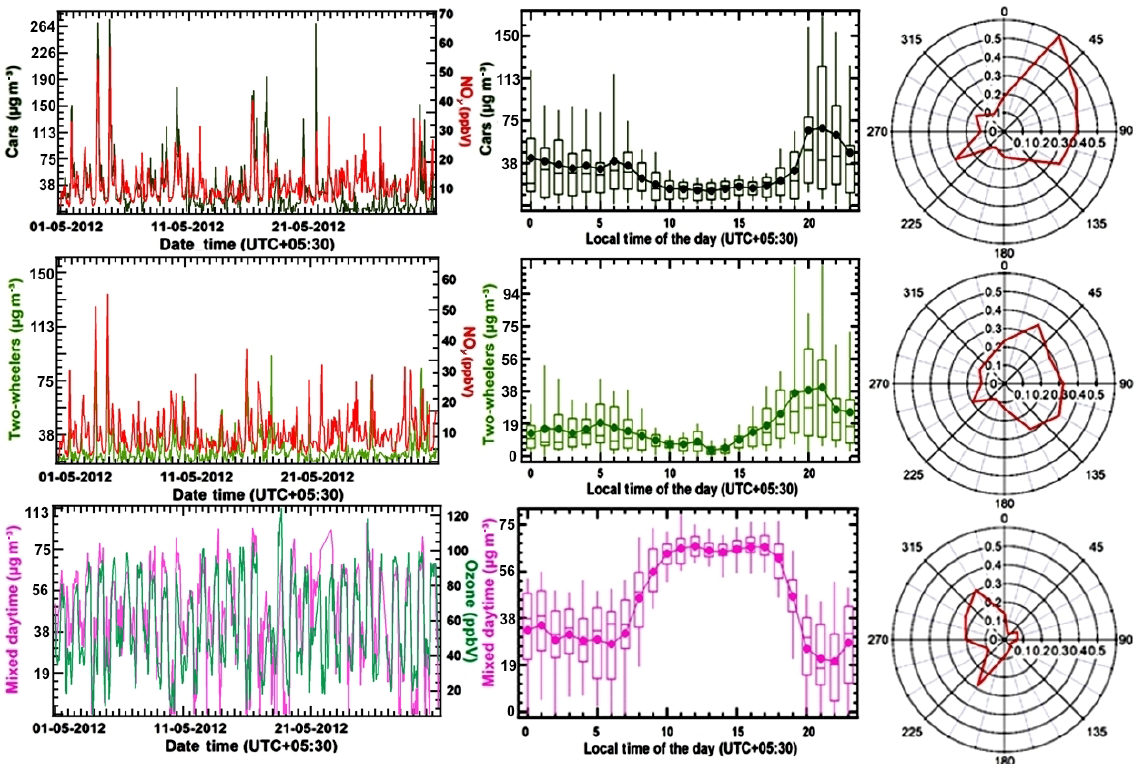
Figure 7. Factor contribution time series, factor diel variability and CPF plot for PMF factor 4 and factor 5 (cars and two-wheelers) and PMF factor 6 (mixed daytime) for May 2012. The time series of PMF factor’s hourly mass (in µgm − 3 ) is plotted against independent tracer species NO y (in ppbv) for the car and two-wheeler factor and O 3 (in ppbv) for the mixed daytime factor. The diel box-and-whisker plot shows the statistical parameters of factor’s hourly mass contribution (in µgm − 3 ) for every hour of the day plotted against the start time of the hour. The width of the box gives 25th and 75th percentiles, 50th percentile partitions the box; whiskers represent 10th and 90th percentiles of the dataset and average values are given by solid